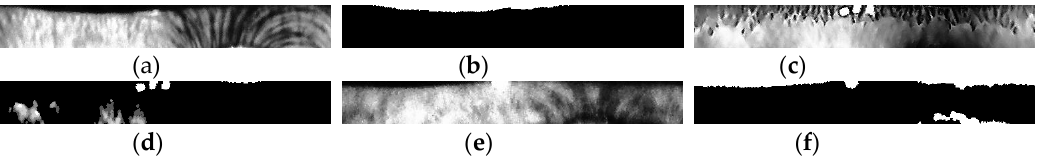
Figure 10. The example of a normalized image. ( a ) Normalized enhanced image of Figure 2b, ( b ) normalized image of Figure 9b, ( c ) normalized enhanced image of Figure 2d, ( d ) normalized image of Figure 9d, ( e ) normalized enhanced image of Figure 2f, ( f ) normalized image of Figure